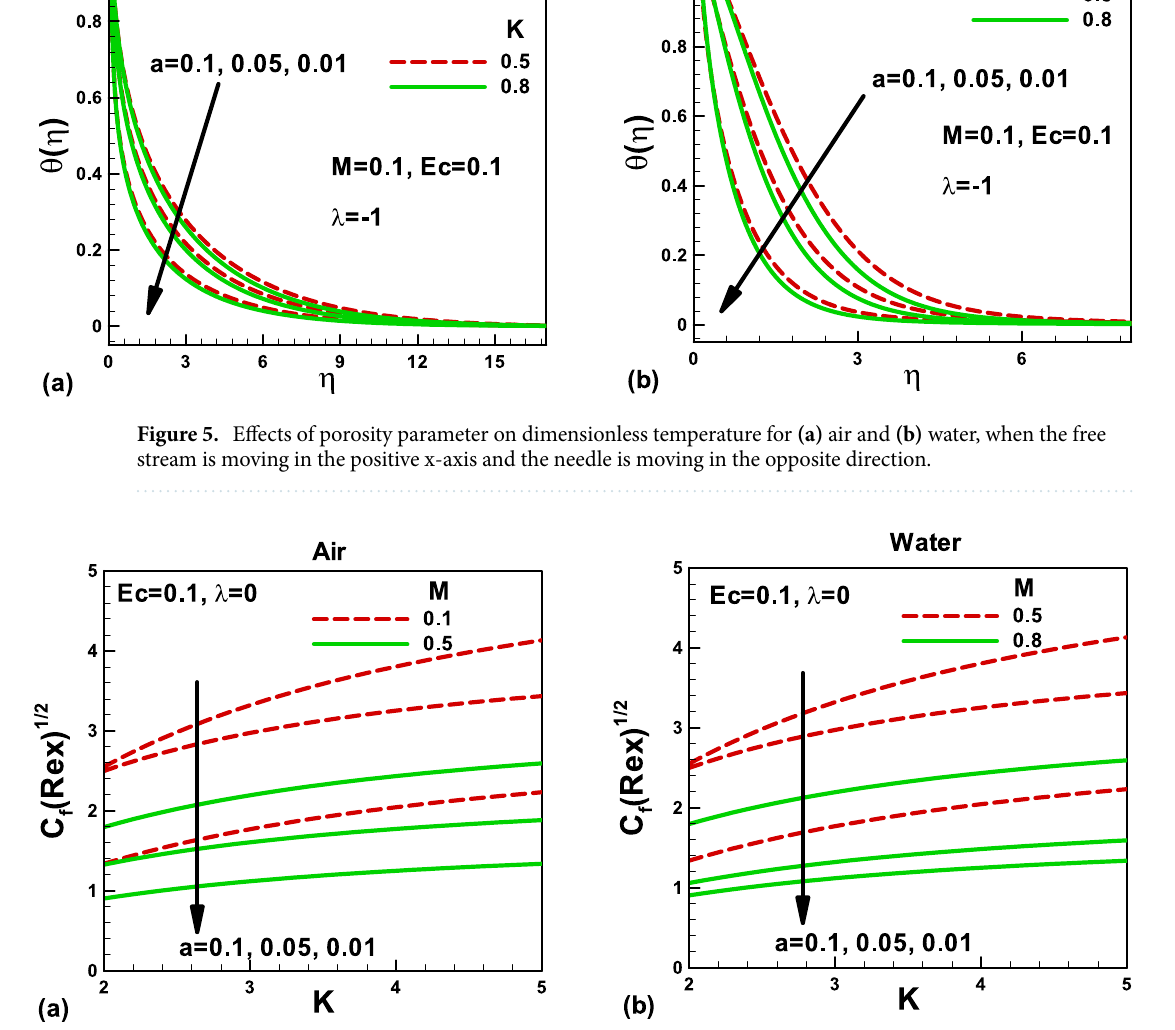
Figure 6. Effects of magnetic and porosity parameters on skin friction for (a) air and (b) water, when the needle is fixed in a moving